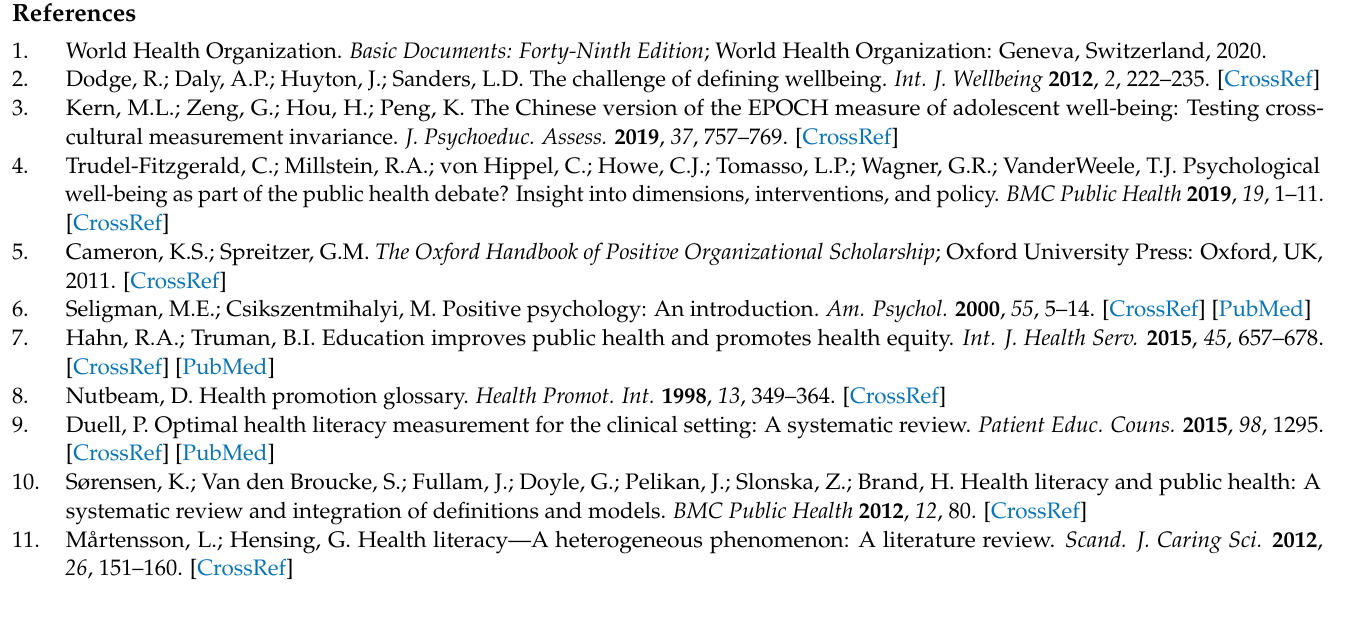
parent sample, Table S3: Factor loadings of the Well-Lit 6 and other wellbeing measures in the school staff